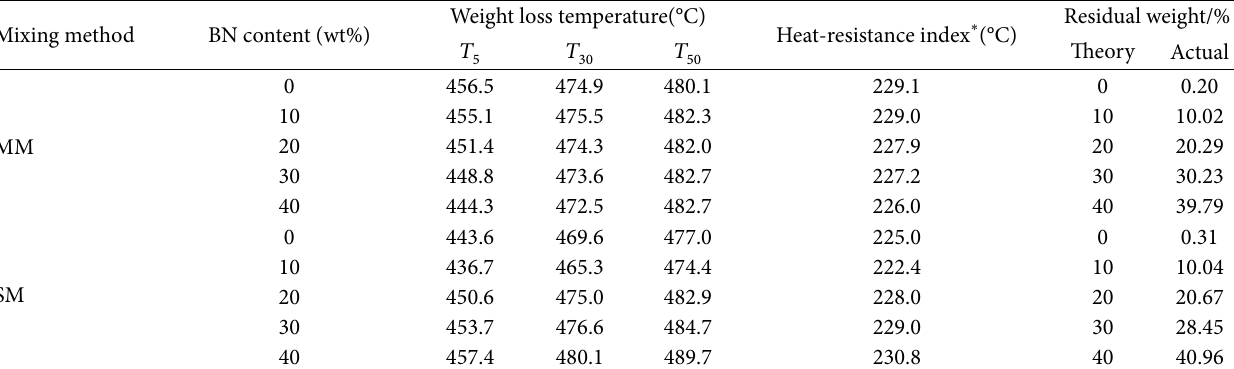
Table 2: Thermal data of UHMWPE/BN composites from TG